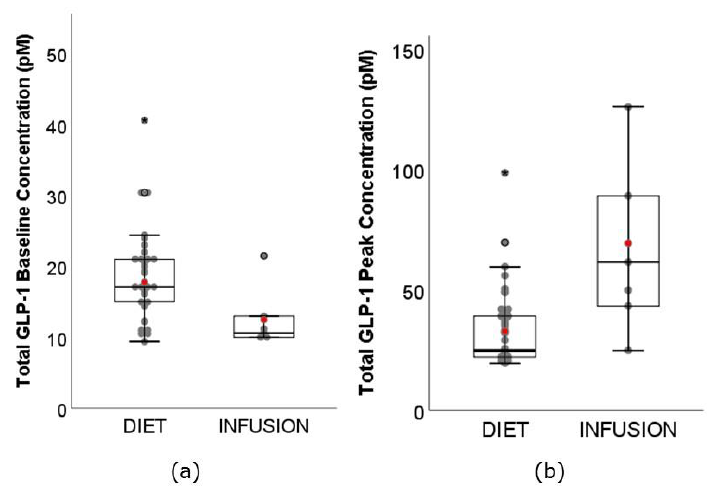
Figure 4. Boxplots showing the ( a ) baseline concentration, and ( b ) C max, peak concentration of total GLP-1 between DIET (N = 479, K = 37) and INFUSION (N = 67, K = 6). The weighted means were significantly different between DIET and INFUSION for all ( p < 0.01, all).